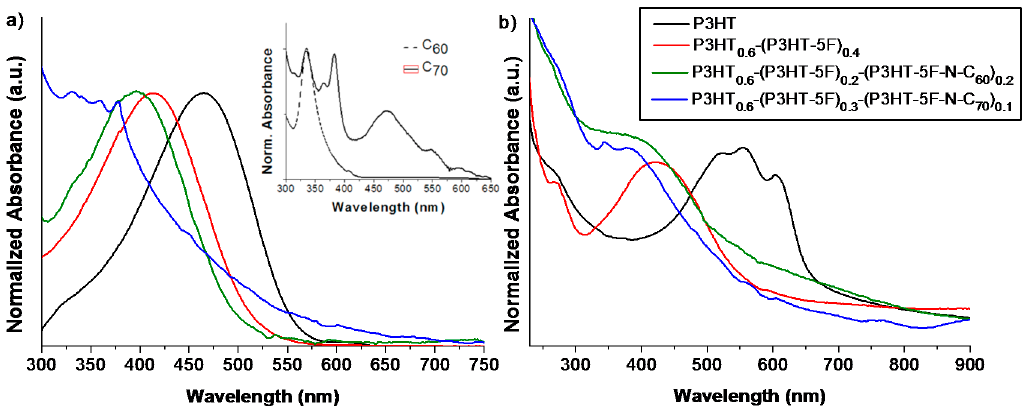
Figure 8. Normalized Absorption spectra in: ( a ) o -DCB solutions; and ( b ) film form of un functionalized P3HT, side functionalized [P3HT 0.6 -(P3HT-Br) 0.4 ], [P3HT 0.6 -(P3HT-5F) 0.4 ], [P3HT 0.6 -(P3HT-5F) 0.2 -(P3HT-5F-N-C 60 ) 0.2 ] and [P3HT 0.6 -(P3HT-5F) 0.3 -(P3HT-5F-N-C 70 ) 0.1 ], respectively. The inset in ( a ) shows the Normalized Absorption spectra of C 60 and C 70 in o -DCB solutions.